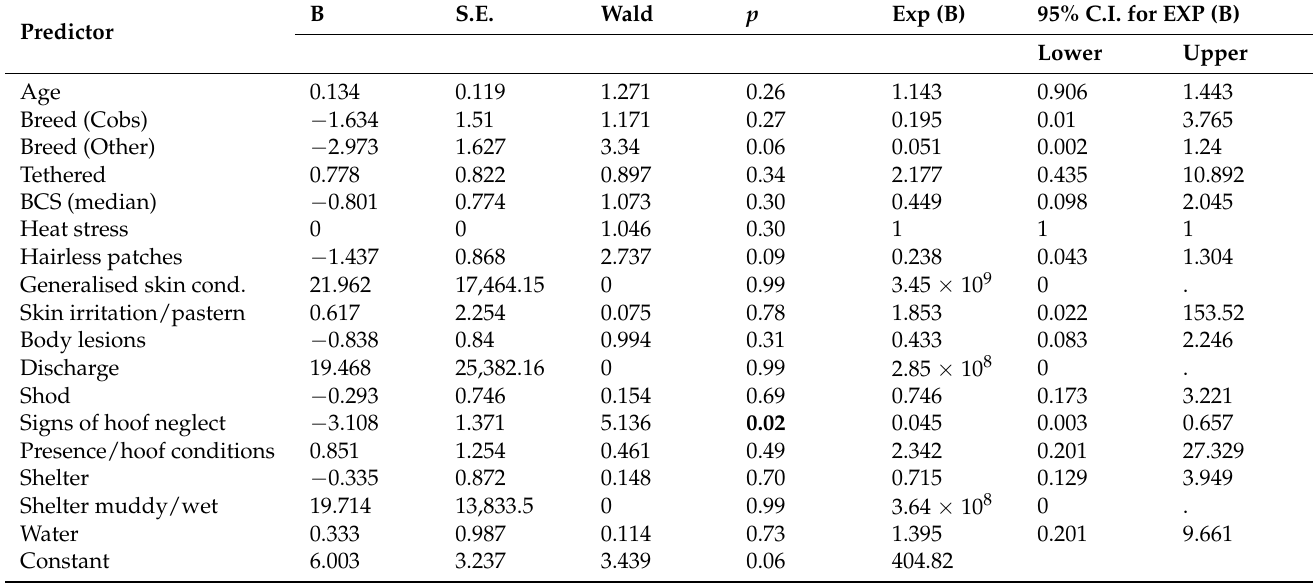
Table 7. Binomial logistic regression predicting likelihood of friendly response (0 = absent, 1 = present) to the human approach test on predicting variables ( n = 104). Significant results are bolded (p < 0.05), degrees of freedom =